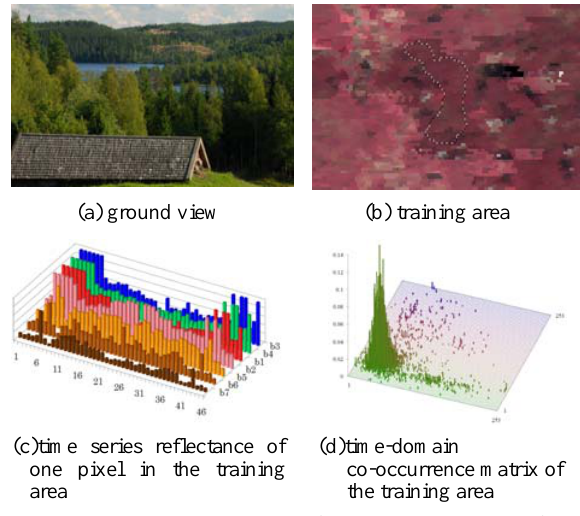
Figure 5. Training data example for "evergreen needleleaf forest".